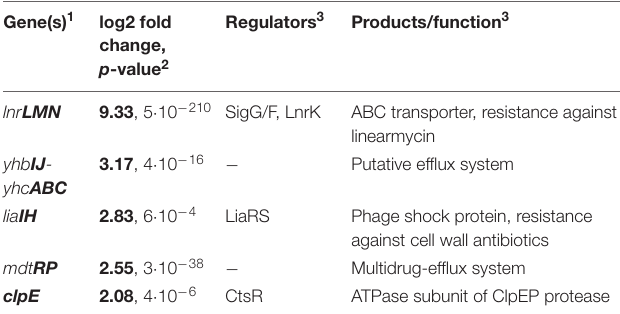
TABLE 3 | RNA-seq